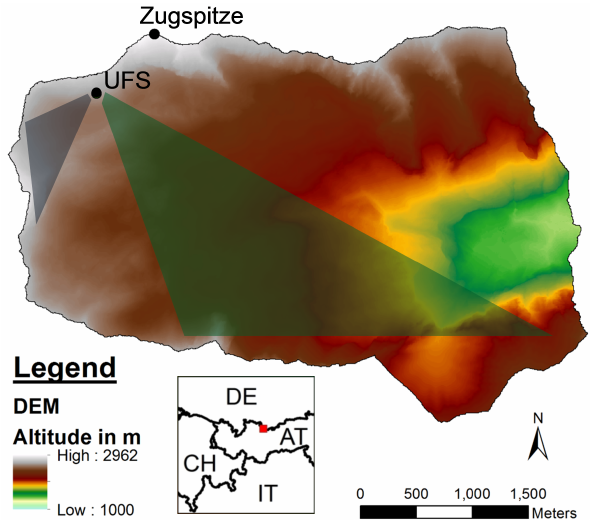
Figure 1. DEM of the Zugspitzplatt catchment at the border of Germany and Austria and the sketched fields of view of the cam- eras installed at the Environmental Research Station Schneeferner- haus (UFS; 2650m): the single lens reflex camera (SLR) monitors Schneefernerkopf summit in the south-west of the UFS (blue) and the webcam is directed towards the south-eastern Zugspitzplatt area